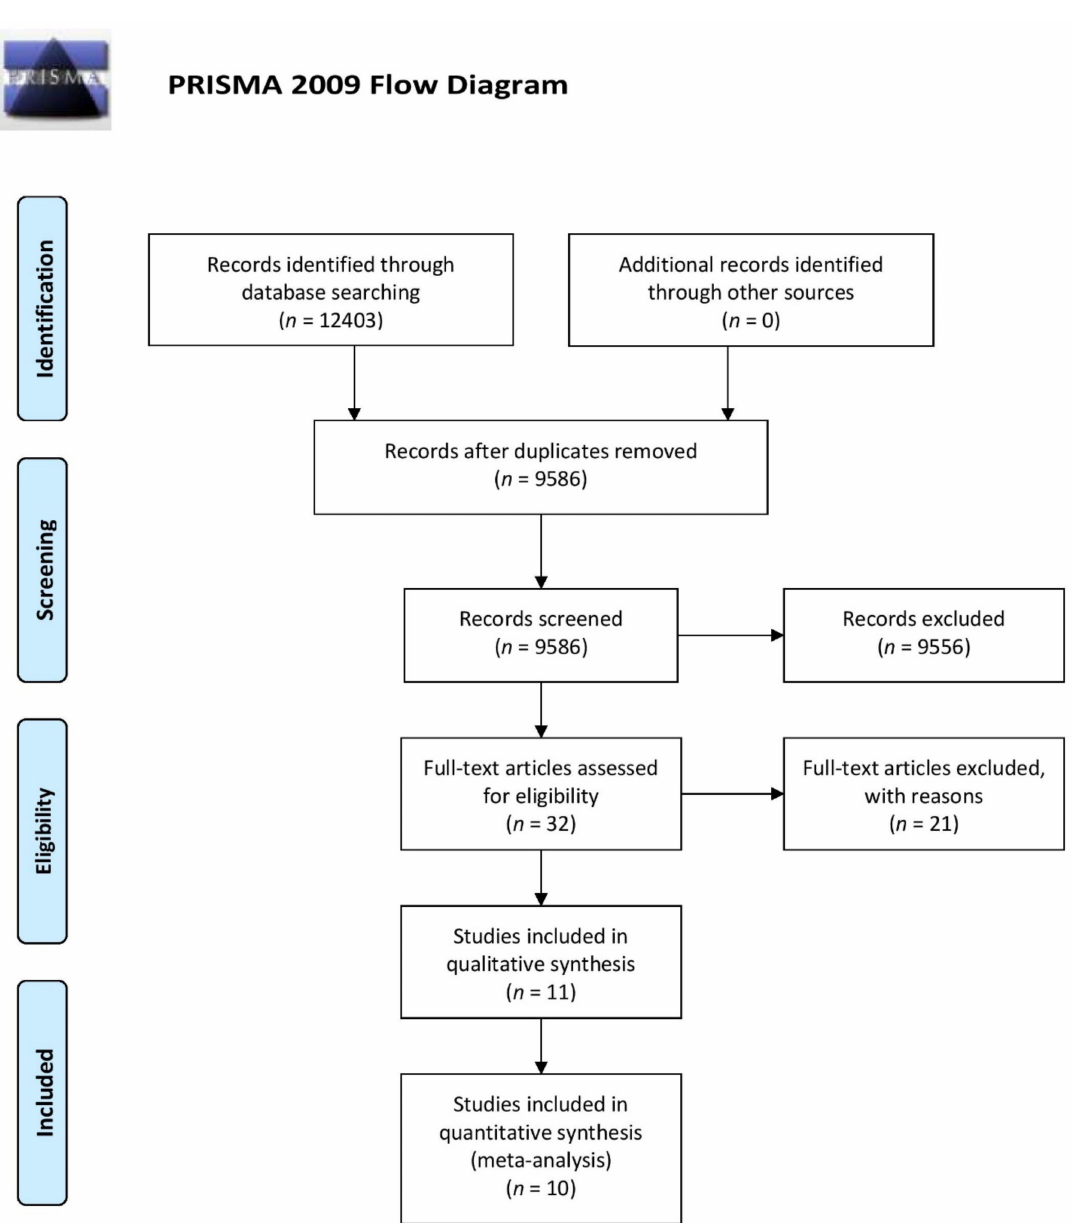
Figure 1. Preferred Reporting Items for Systematic Reviews and Meta-Analyses (PRISMA) flow